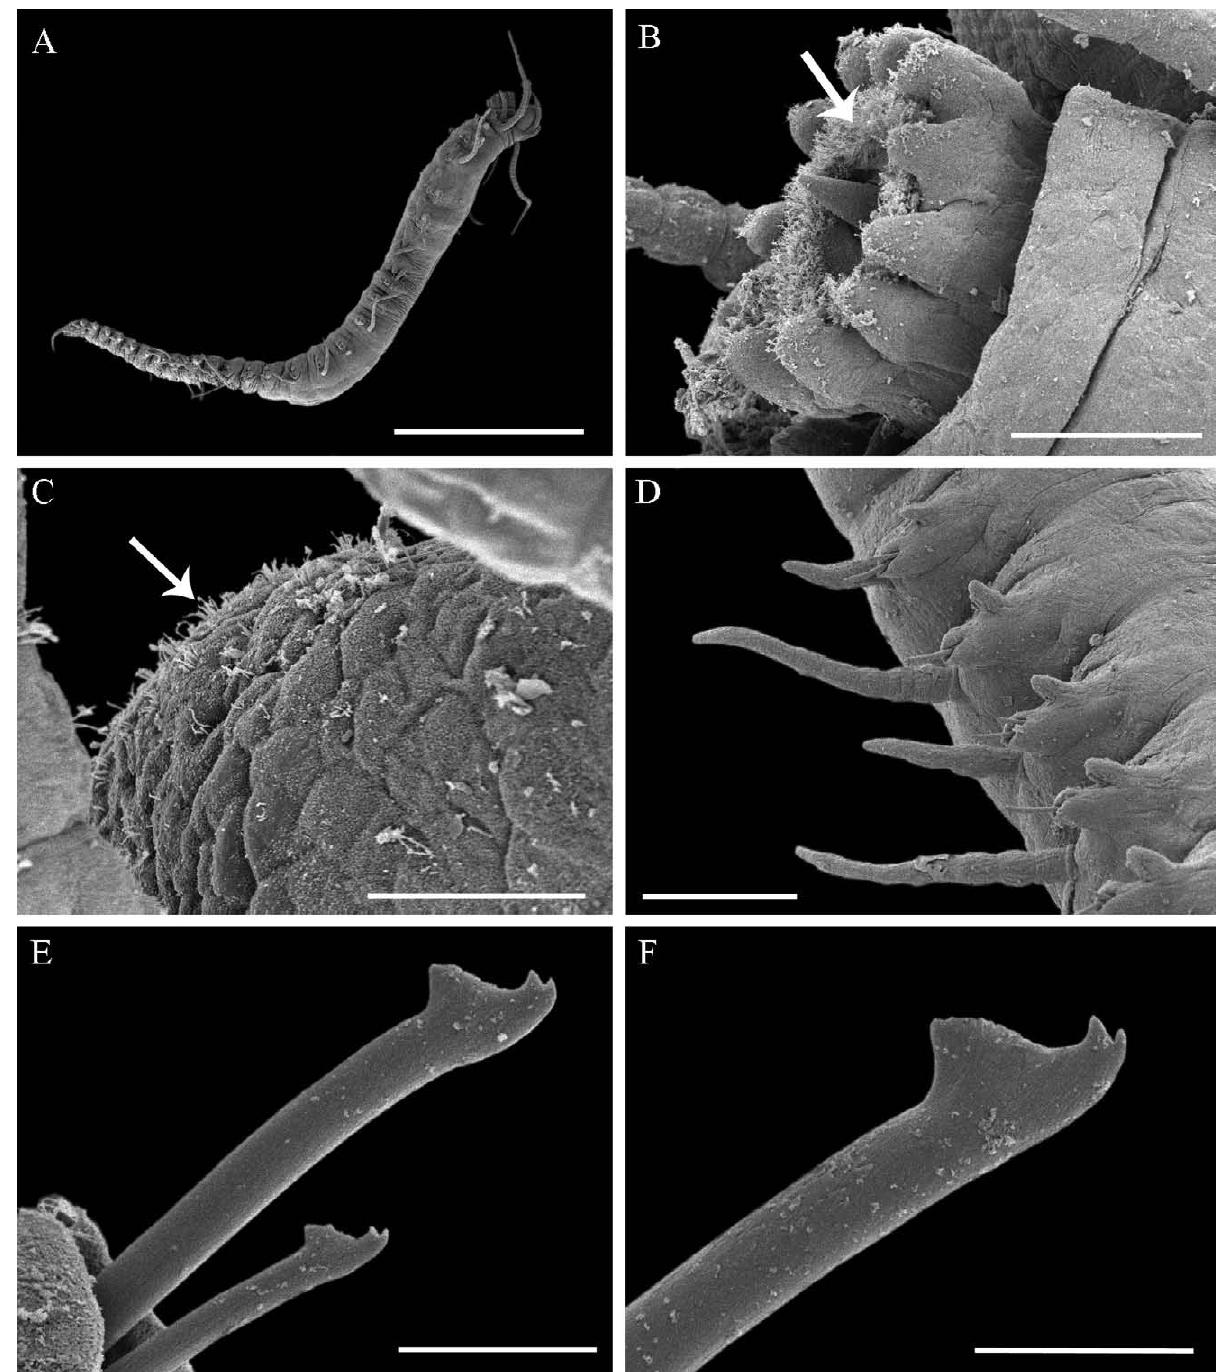
Fig . 2. – SEM micrographs of Haplosyllis aplysinicola n. sp. A, whole body, ventral view. B, pharynx showing anterior tooth, soft papillae and ring of cilia (indicated by arrow). C, upper-ventral side of palps, arrow points on cilia. D, mid-body parapodia, cirri alternating with long and short. E, anterior chaetae, chaetiger 5. F, mid-body chaeta. Scale bars: A (1 mm), B (500 um), C (20 m m), D (100 m m), E-F (10 m m). Paratypes INV-ANE